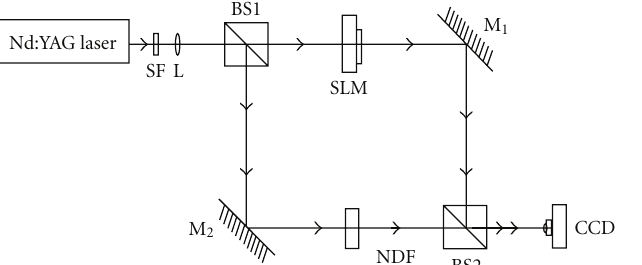
Figure 3: Mach-Zehnder interferometer. SF: spatial filter, BS1 and BS2: beam splitters, L: lens, M 1 and M 2 : mirrors, NDF: neutral density filter, CCD: camera, and SLM: spatial light modulator assembly.